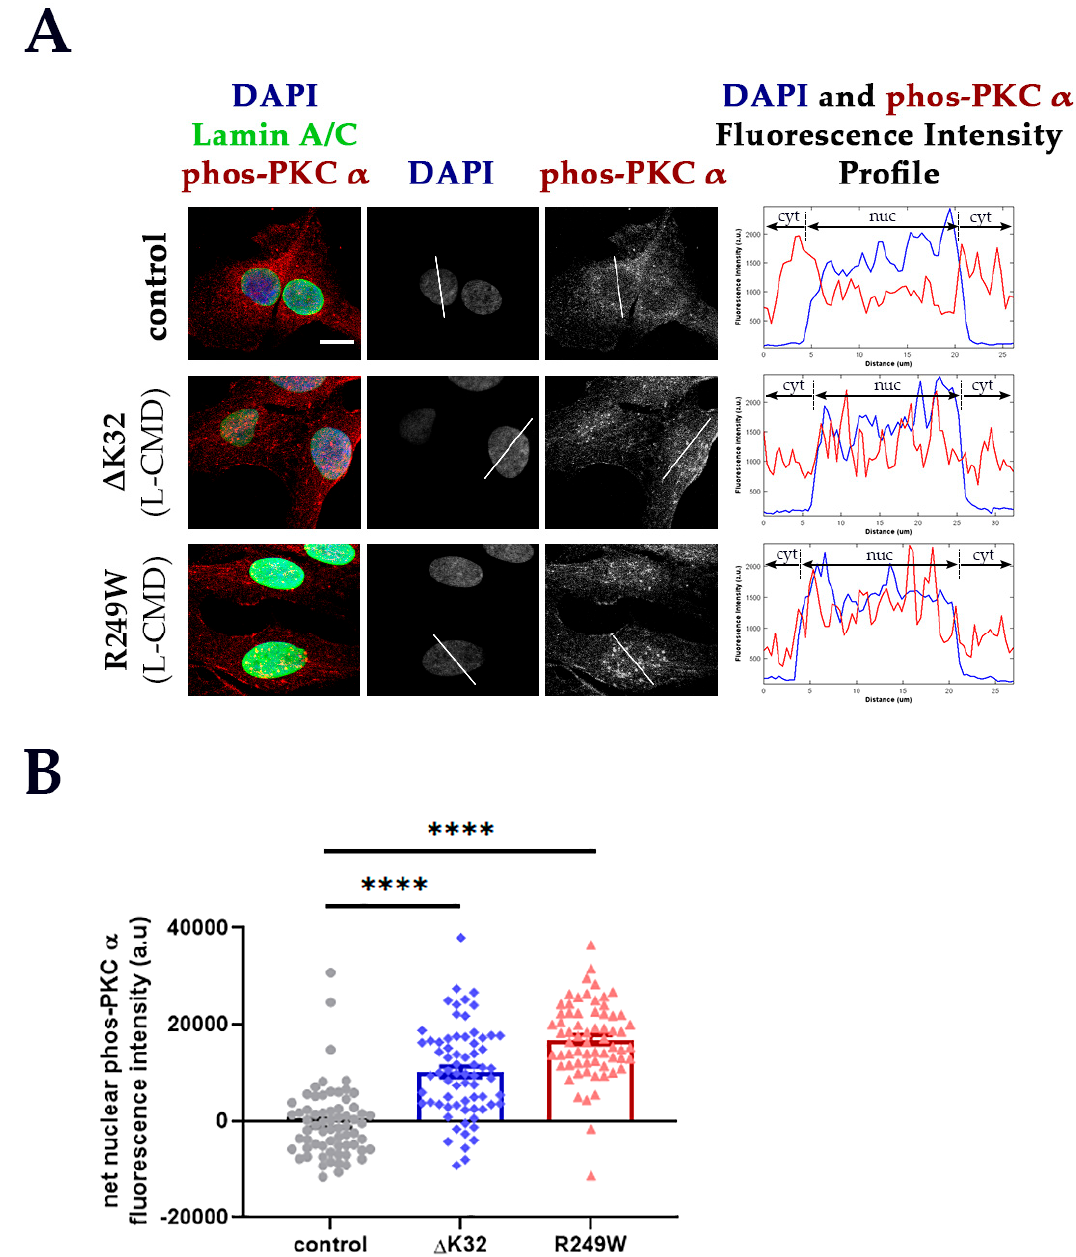
Figure 3. Cellular localization of phosphorylated PKC- α (phos-PKC- α ) in control and patient myoblasts. ( A ) Immunostaining for DAPI, lamin A / C and phos-PKC- α in control and patient myoblasts. The composite image showing DAPI, lamin A / C and phos-PKC- α for each group is shown in the leftmost panel. The white line across a cell in the DAPI and phos-PKC- α panels indicates the measurement path used to generate the fluorescence intensity profiles for DAPI and phos-PKC- α shown in the rightmost panel. TheplotprofileforDAPIisincludedtoshownucleardemarcationoffluorescencesignal. Scalebar: 15 µ m for all immunofluorescence images. ( B ) Mean ( ± SEM) net nuclear phos-PKC- α fluorescence intensityof eachgroup: control(greycircles), ∆ K32(blue diamonds)andR249W(pink triangles). The net nuclear phos-PKC- α fluorescence intensity of each cell = adjusted nuclear phos-PKC- α fluorescence intensity − mean of the adjusted cytoplasmic phos-PKC- α fluorescence intensities. n = 2 technical replicates (one patient / group; ≥ 66 cells / group were analyzed). Significance **** means p <